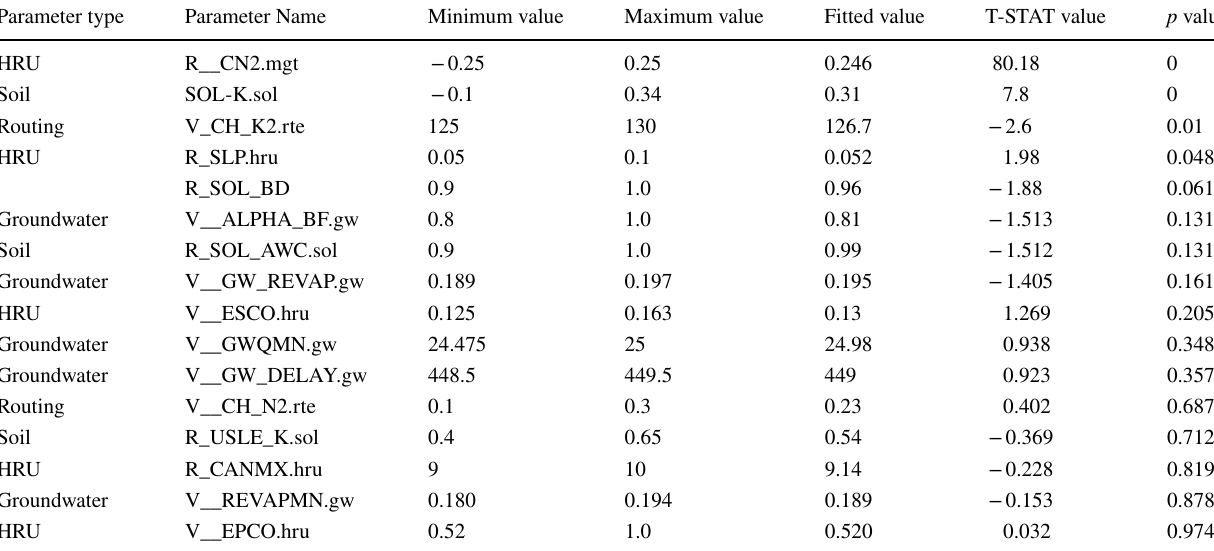
Table 5 Global Sensitive flow parameters